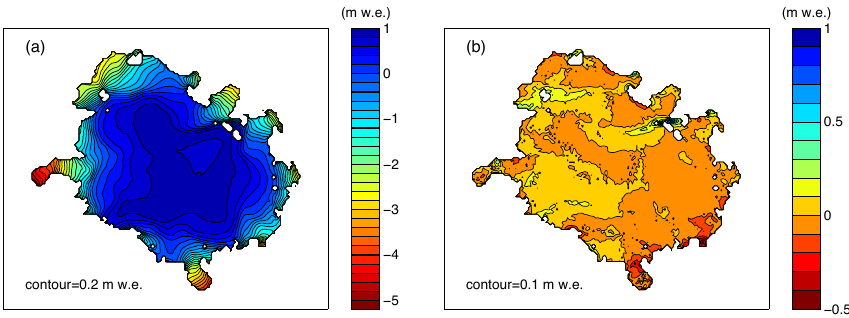
Fig. 7. (a) Mean and (b) altitudinal deviation of the net mass balance distribution for the period 1961–1990, modelled with local meteorolog- ical data. For each grid cell, the altitudinal deviation gives the mass balance deviation from the mean net mass balance for the corresponding 5m altitude